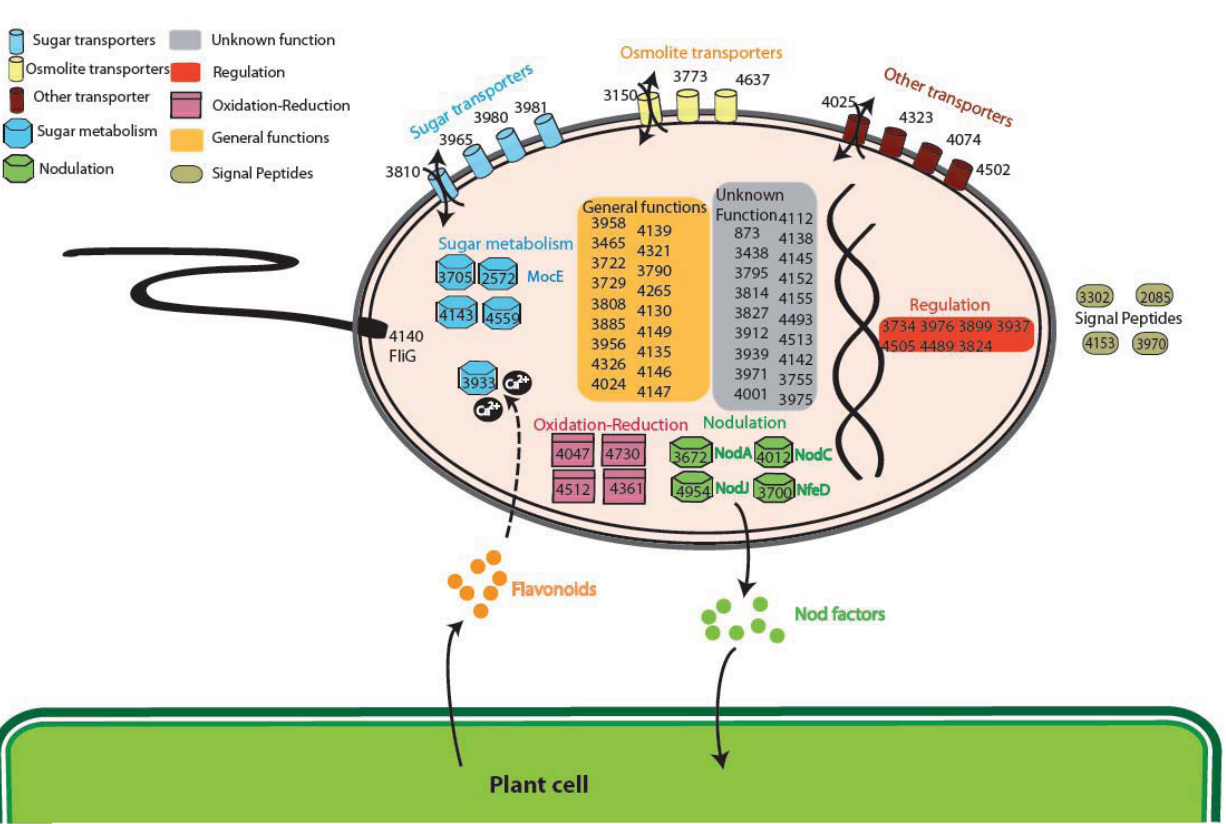
Figure 4. Overview of the cellular functions of the Plant Symbionts gene set. Go categories are color coded. Numbers represent orthologous groups (see Supplementary Material